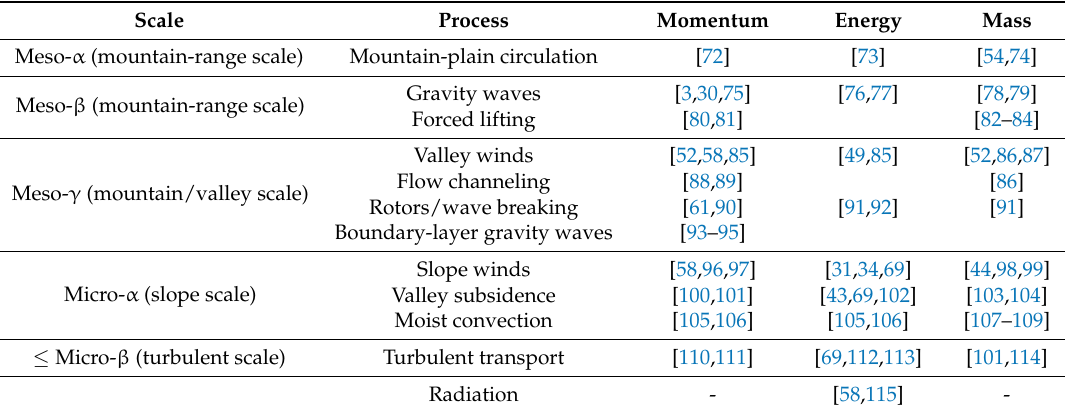
Table 1. List of transport and exchange processes over mountainous terrain for momentum, energy, and mass. The references in columns 3–5 relate to studies in which specifically exchange of momentum, energy and mass has been studied or observed. The lists of references are non-exhaustive; no more than three references are shown for either process and exchange